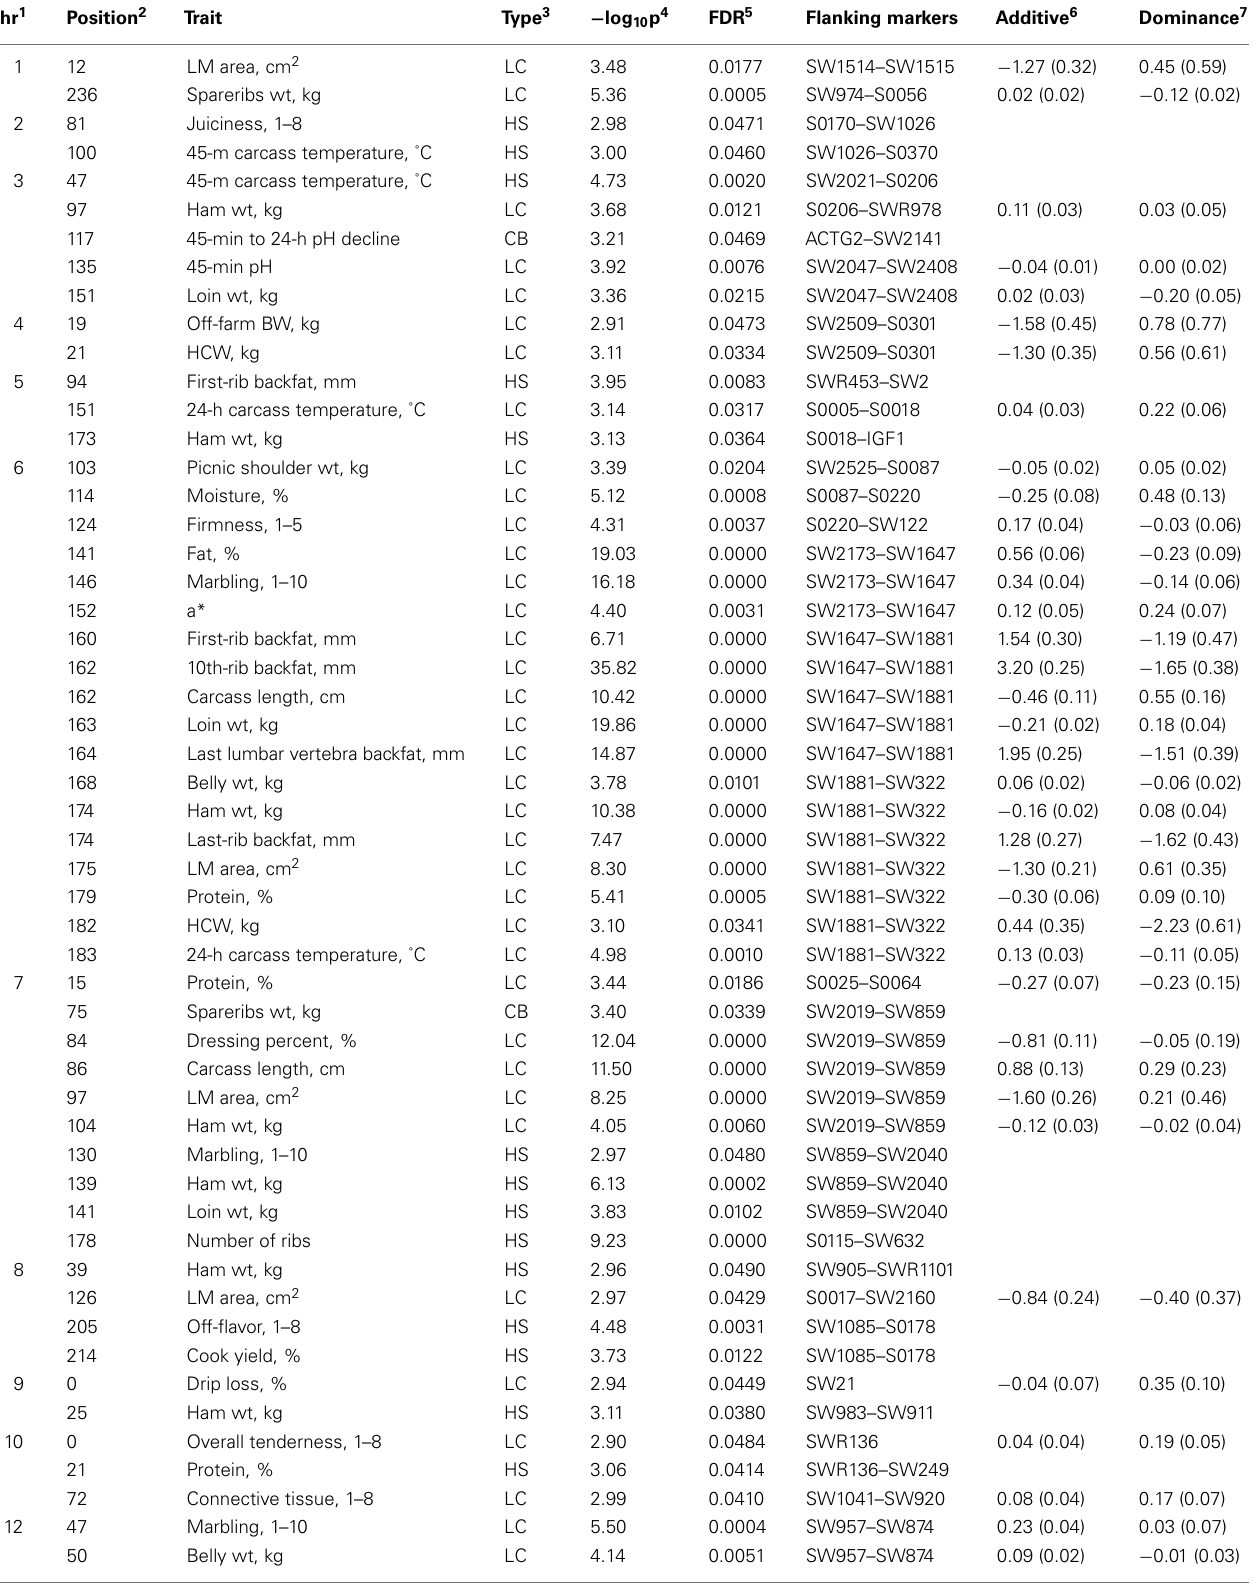
Table 2 | Position and significance level of carcass and meat quality trait